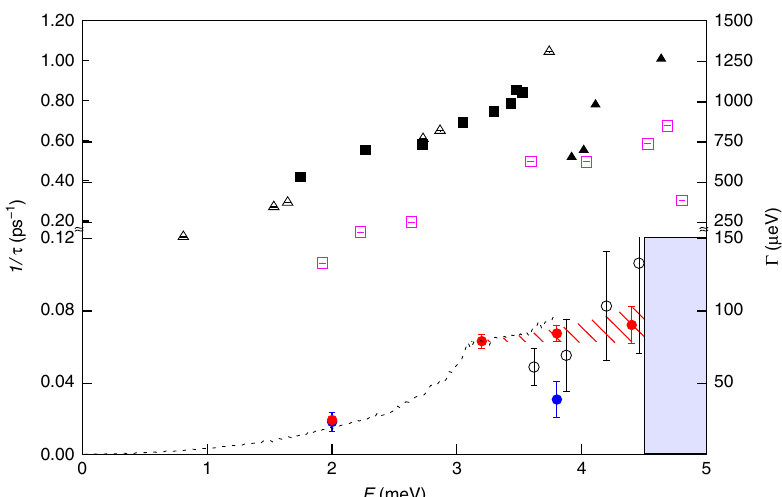
inverse phonon lifetimes ( left ) and Fig. 5 Energy and temperature dependences of transverse acoustic (TA) phonon lifetimes in Ba 7.81 Ge 40.67 Au 5.33 . TA 100 011 energy Full Width at Half Maximum (FWHM, right ) as determined from measurements on the neutron triple axis spectrometer (TAS, black circles ) and the neutron resonant spin-echo (NRSE) spectrometer as a function of energy at 300 K ( full red circles ) and at 10 K ( full blue circles ). Above 4.5 meV the extraction of a single acoustic phonon mode lifetime is no longer possible due to the proximity of a low lying optical excitation ( blue shaded area ). Vertical error bars are standard deviation obtained by error propagation during the fi tting procedure. The dotted line shows the rescaled calculated phonon density of state (p-DOS( ω ), in meV − 1 ; see Supplementary Note 5) which is truncated at E = 3.8 meV due to van Hove singularities. The calculated phonon lifetime from DFT (see text) for the TA 100 mode is shown as ( empty pink squares ). Previous experimental determination of acoustic phonon lifetimes in the same 011 energy range are reported for PbTe ( full black squares , Delaire et al. 17 ), AgSbTe 2 ( empty triangles , Ma et al. 19, 21 ) and amorphous Silica ( full black triangles , Baldi et al. 48